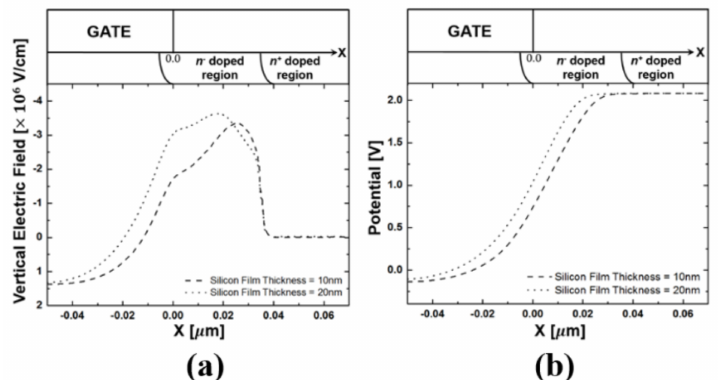
Figure 12. ( a ) Vertical electric field distribution and ( b ) lateral potential distribution on the silicon surface near the drain region for the PiFETs when V GS = − 0.5 V and V DS = 1.6 V.